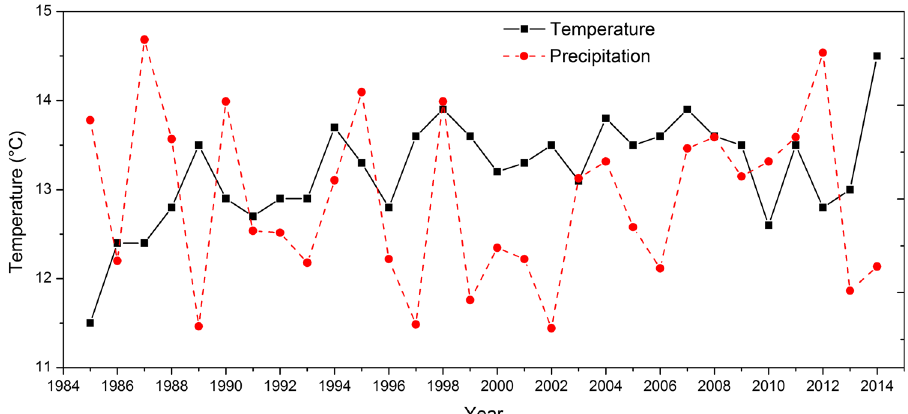
Fig. 5 Variation of temperature and precipitation in the study